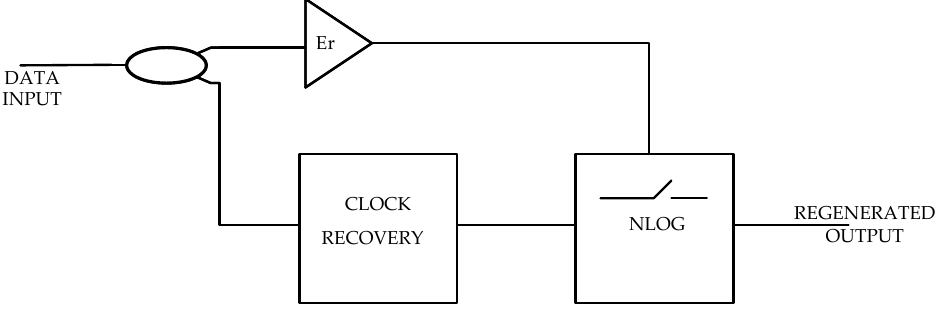
Figure 3. Block scheme of an